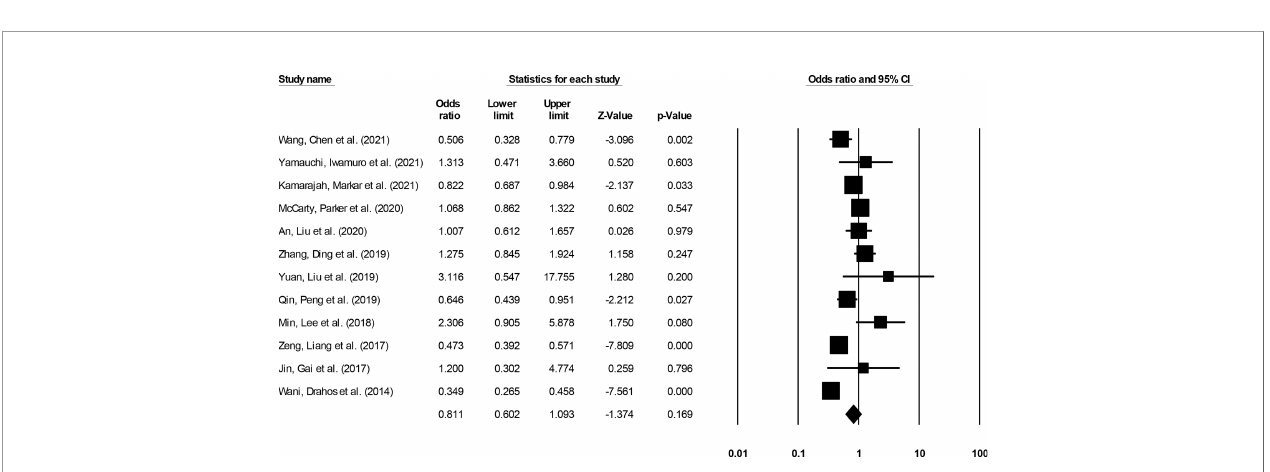
FIGURE 10 | The forest plot for studies evaluating the long-term survival outcome in patients with super fi cial esophageal squamous cancer undergoing endoscopic submucosal dissection or esophagectomy. The odds ratios are presented as black boxes whereas 95% con fi dence intervals are presented as whiskers. A higher odds ratio represents higher odds of long-term survival outcome for patients receiving endoscopic submucosal dissection, and a lower odds ratio represents higher odds of long-term survival outcome for patients receiving